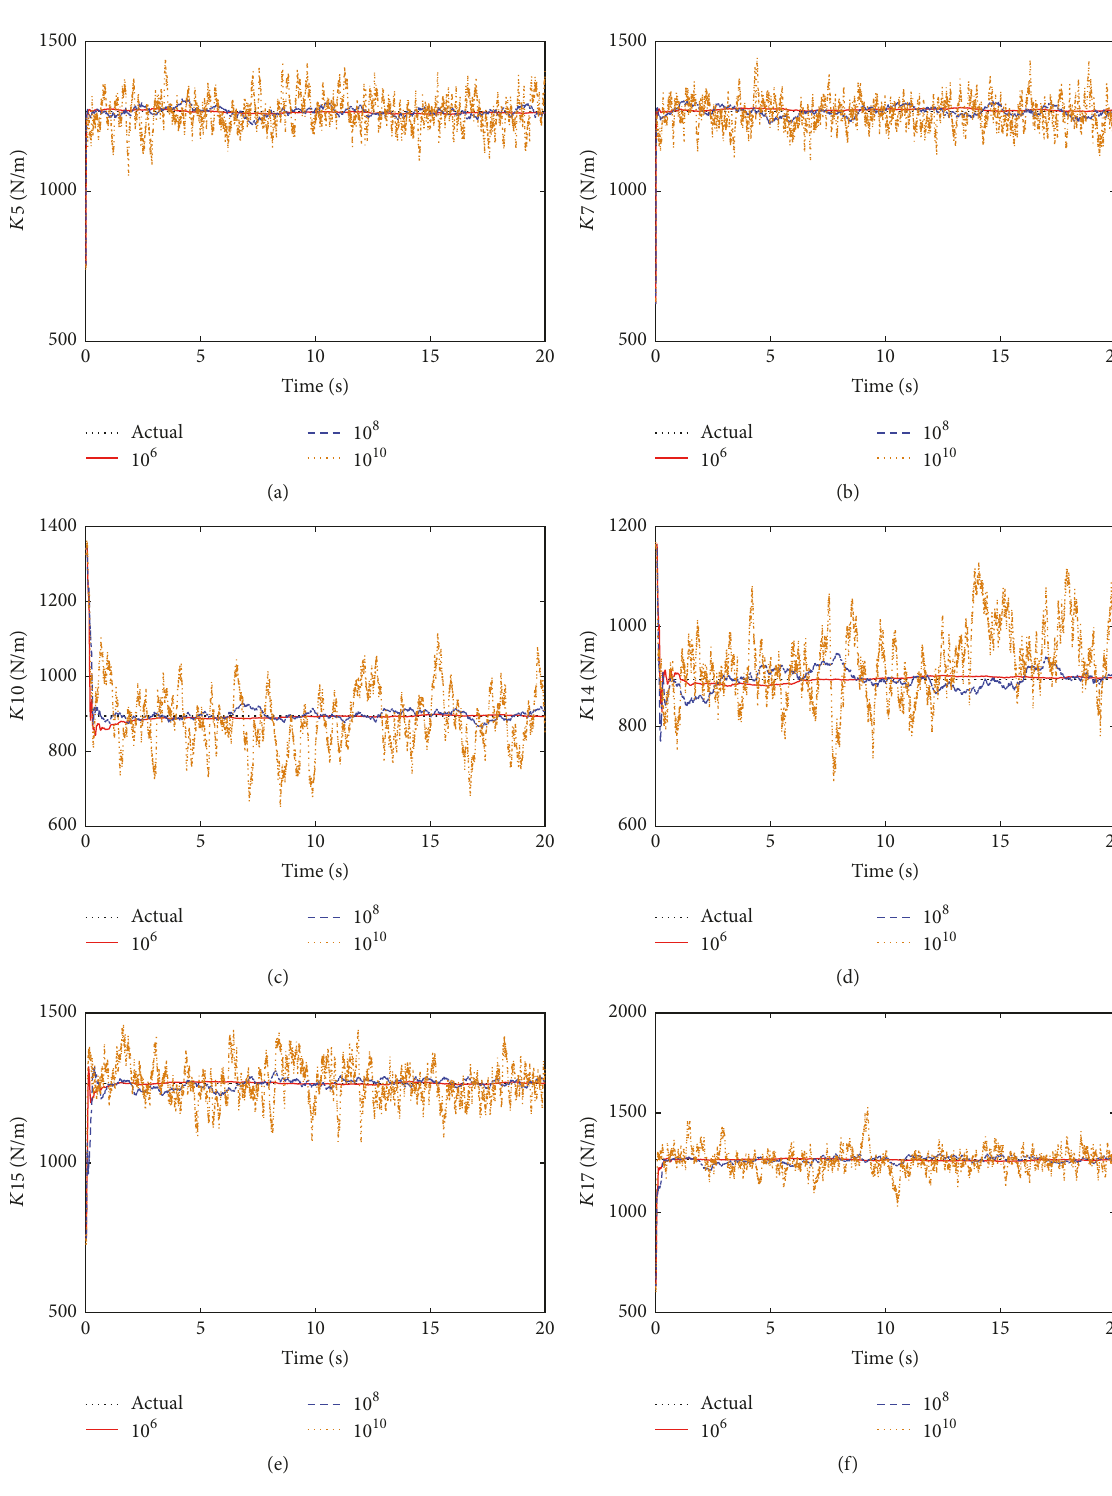
Figure 10: The actual and identified stiffness for Elements 5, 7, 10, 14, 15, and